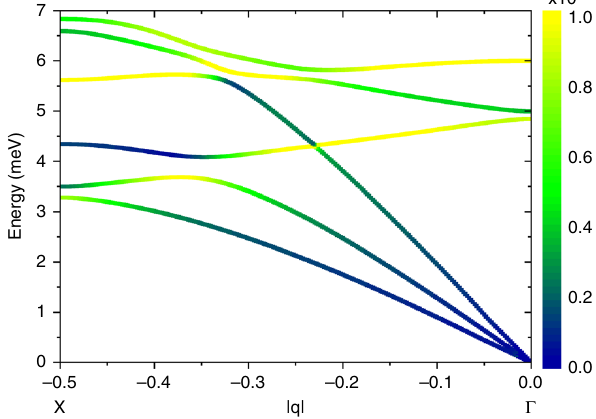
Fig. 8 DFT spin-phonon couplings. Colours map spin-phonon couplings ð ω ; q Þ calculated as in Eq. (1) for the low-energy squared norm V 2 j SPh phonon modes along Γ – X , as a function of j q j . At the ACs the strong coupling of the optical modes is transferred to the acoustic